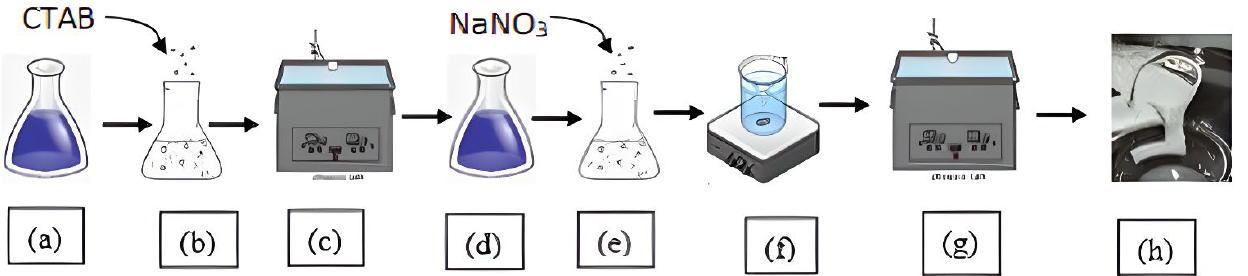
Figure 2. Process of preparation of type1 viscoelastic fluid without nanoparticle additives; Steps (a–c) show the process for preparation of surfactant solution and steps (d–h) depict the process of formation of SBVEF; steps (c,g) show ultrasonication process and step (f) shows magnetic stirring.